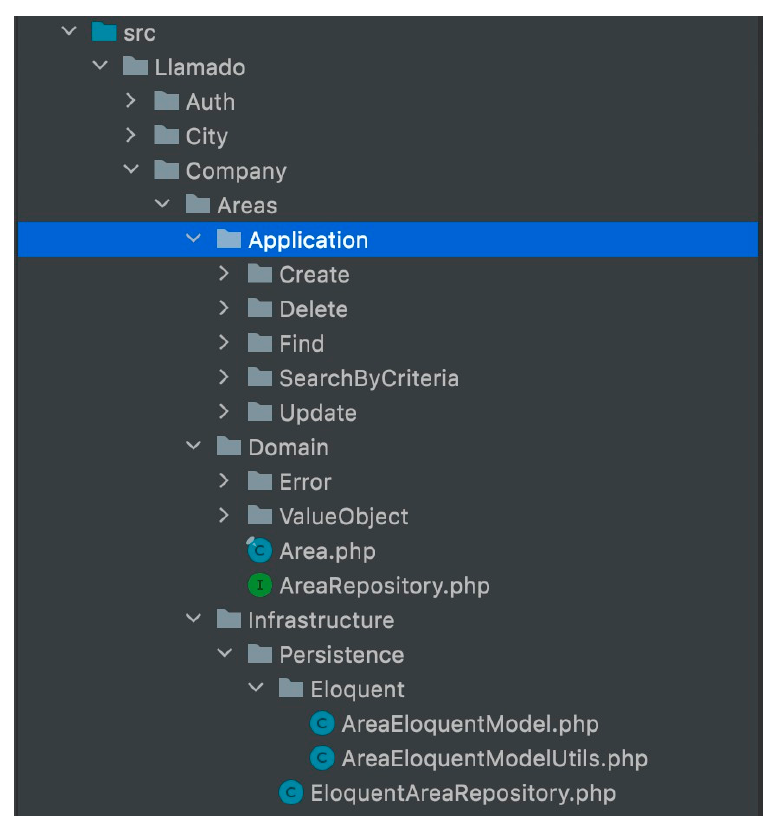
Figure 7. SIAP Hexagonal Platform Architecture.